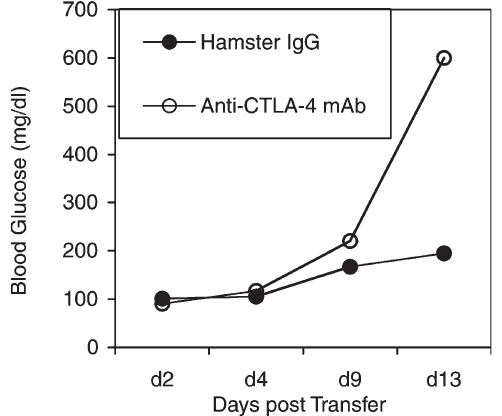
FIGURE 4 Immunization of RIP-HEL recipients of naı¨ve 3A9 T cells fails to trigger diabetes induction unless the CTLA-4 pathway is blocked. 2.5million 3A9 T cells were transferred to RIP-HEL recipients that were immunized with alum-precipitated HEL protein 24h later. 100 m g anti- CTLA-4 antibody or control antibody (hamster IgG) was injected intraperitoneally on days 0, 2, 4 and 6.